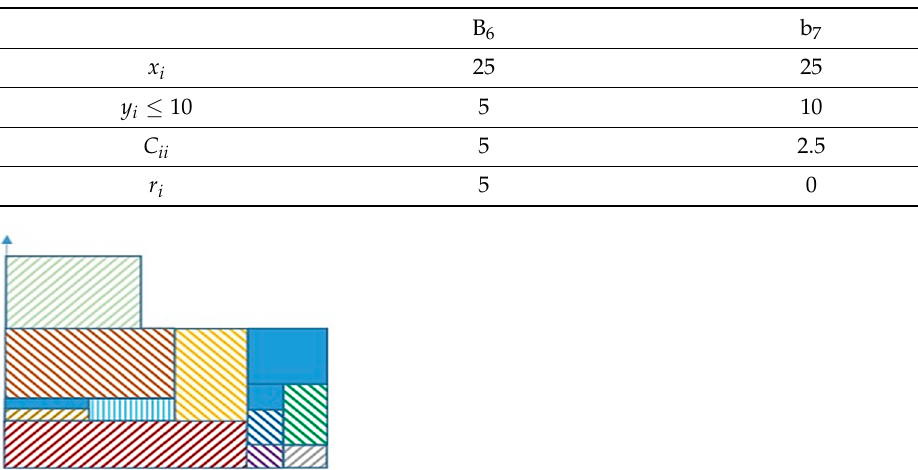
Table 13. Sub-matrix to determine the preferred box b i .